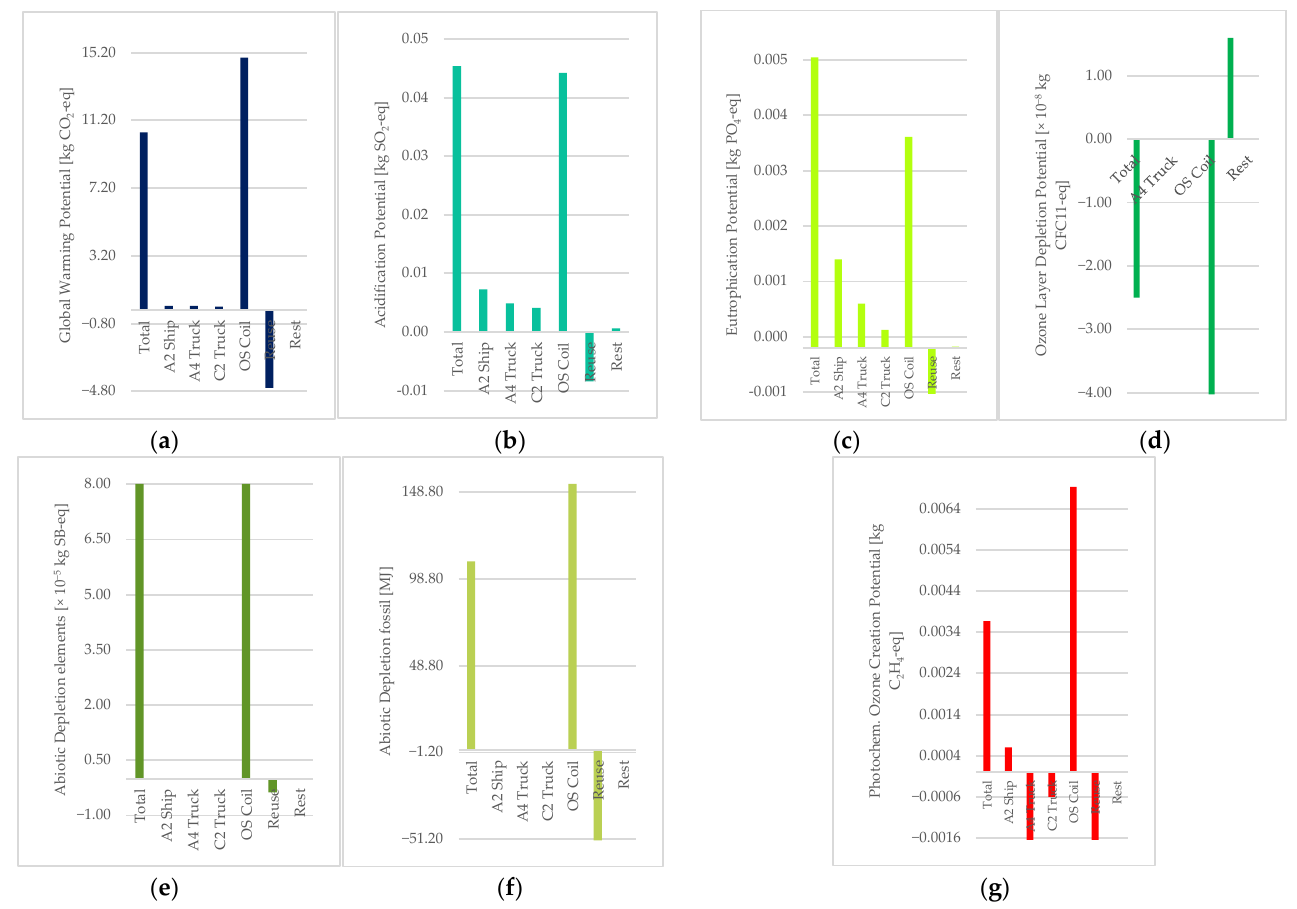
Figure 6. Outputs from GaBi showing the environmental impacts of a steel roof profile for 1 m 2 of the case study house: ( a ) GWP; ( b ) AP; ( c ) EP; ( d ) ODP; ( e ) ADP elements; ( f ) ADP fossil; ( g ) POCP.